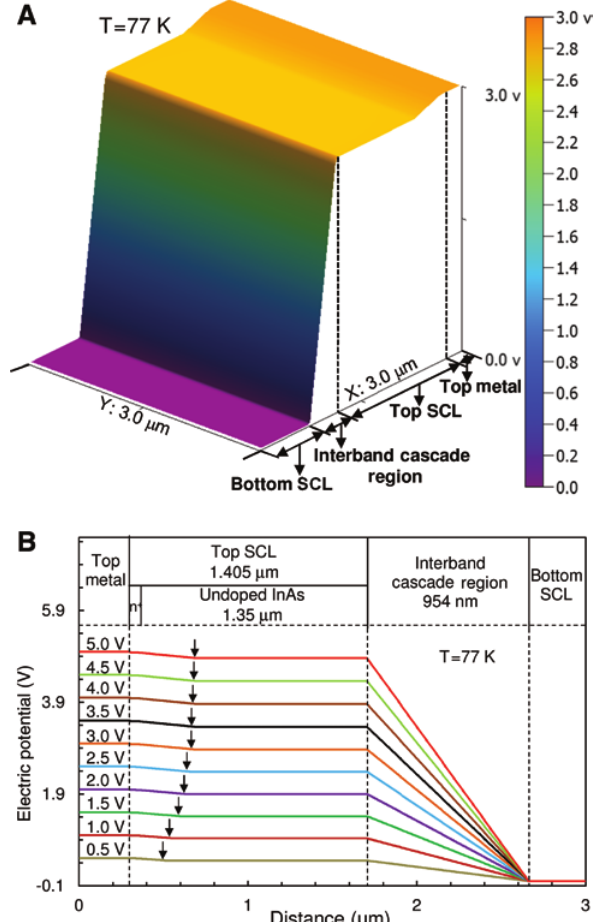
Figure 21: (A) An SVM 2D voltage profile image of an ICL (device bias: 3.0 V, temperature: 77 K). (B) 1D section analysis of the SVM voltage profiles at different device biases from 0.5 to 5.0 V. It shows that the voltage drop mainly occurs across the interband cascade active region of the